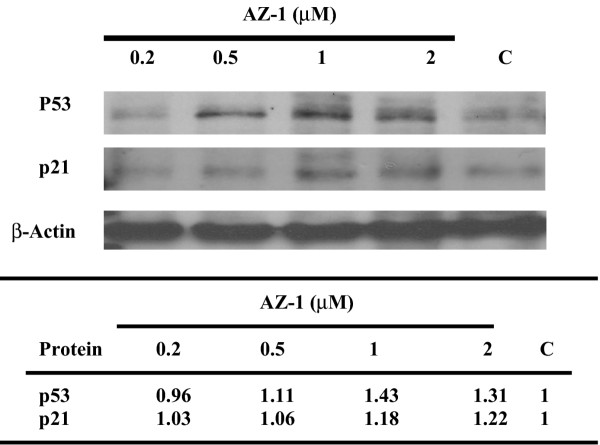
Bis-aziridinylnapthoquinone (AZ-1) alters the expression of apoptotic proteins p53 and p21. The protein expression of p53 and p21 were assessed by immunoblot. The BC-M1 cells were treated with various concentration of AZ-1 (lanes 1–4: 0.2 μM, 0.5 μM, 1.0 μM, and 2.0 μM) for 24 hours and cell lysate was prepared for analysis. Lane 5, untreated control (C). β-actin was an internal control on BC-M1 cells.